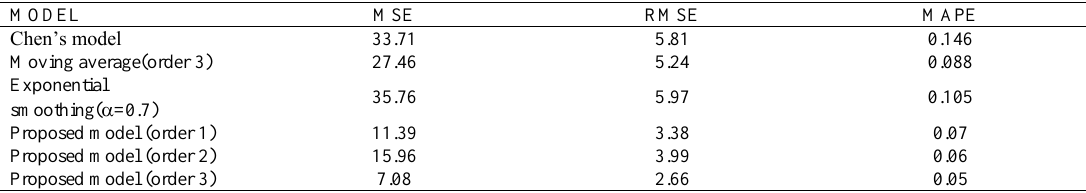
Table 2. Comparative results of training dataset